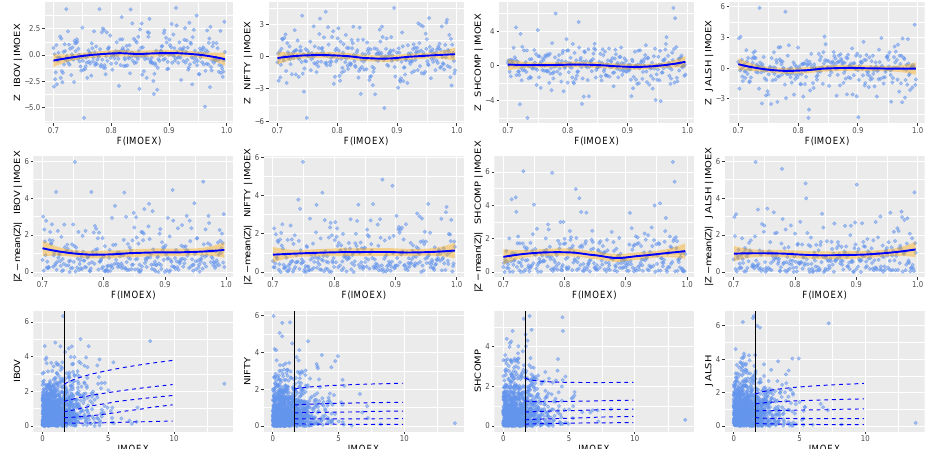
Figure A3. Dependence model diagnostics: conditioning on the IMOEX variable.